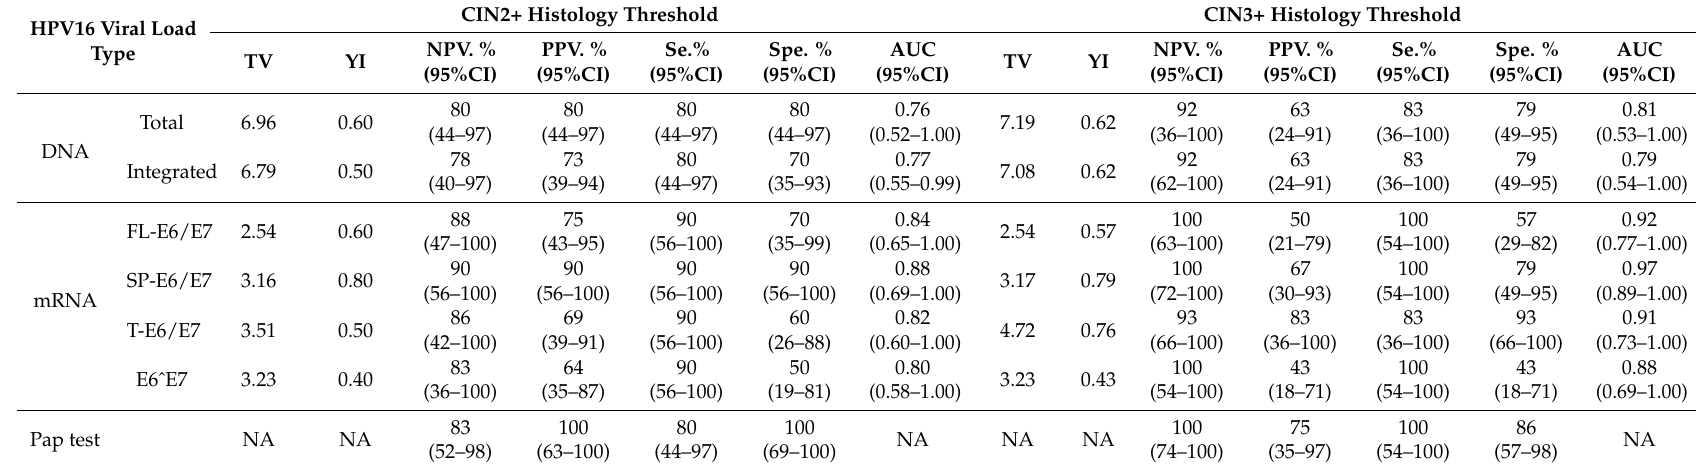
Table 6. Diagnostic performances of the Pap test. HPV16 DNA and E6/E7 mRNA VLs in detection of high grade cervical